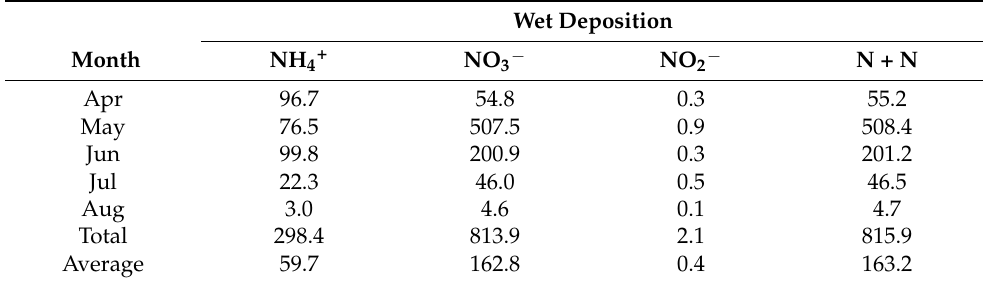
Table 1. Table 1. Monthly water-soluble N wet deposition